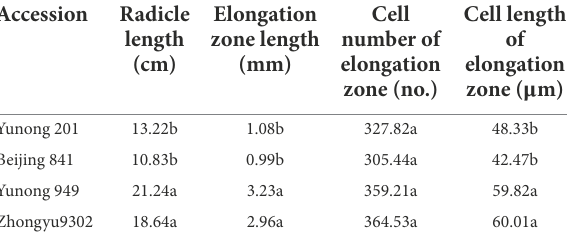
Values followed by different letters in a column mean significant difference among treatments ( p <